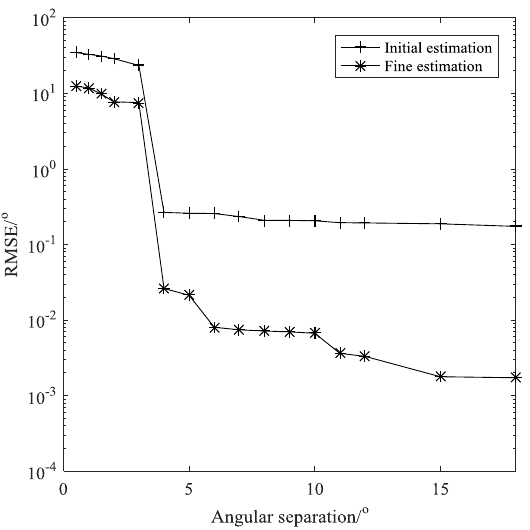
Figure 4. Root mean square error (RMSE) versus angular separation.